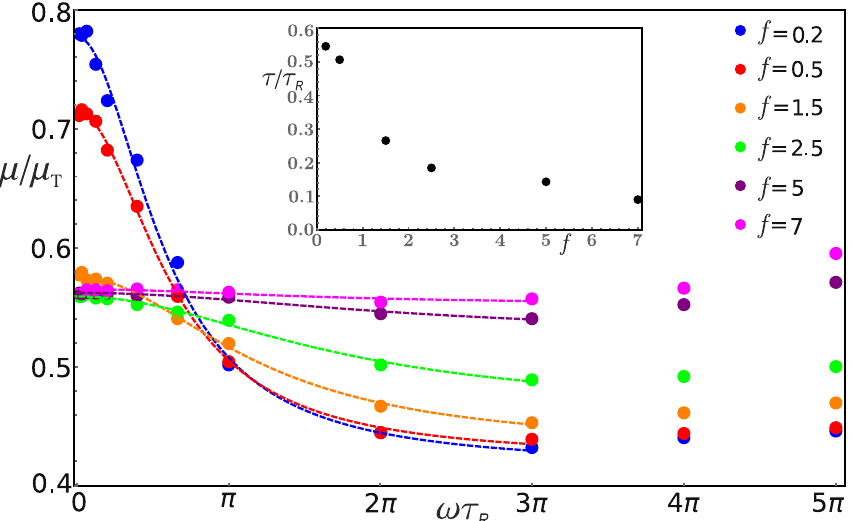
Figure 6. The dynamic mobility of the tracer µ(ω) measured in units of bare mobility µ T as a function of the frequency ω expressed in units of τ − several driving force amplitudes f